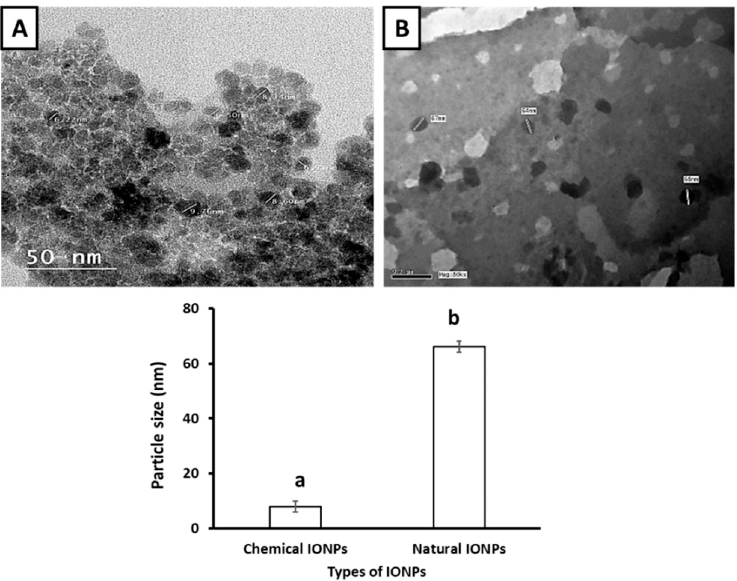
Figure 2. TEMs image of iron oxide nanoparticles biosynthesized using ( A ) chemical method and ( B ) green biosynthesis method with Petroselinum crispum leaf extract. Values are expressed as mean ± standard deviation (SD; n = 5). Data provided by statistical computer system of TEM.